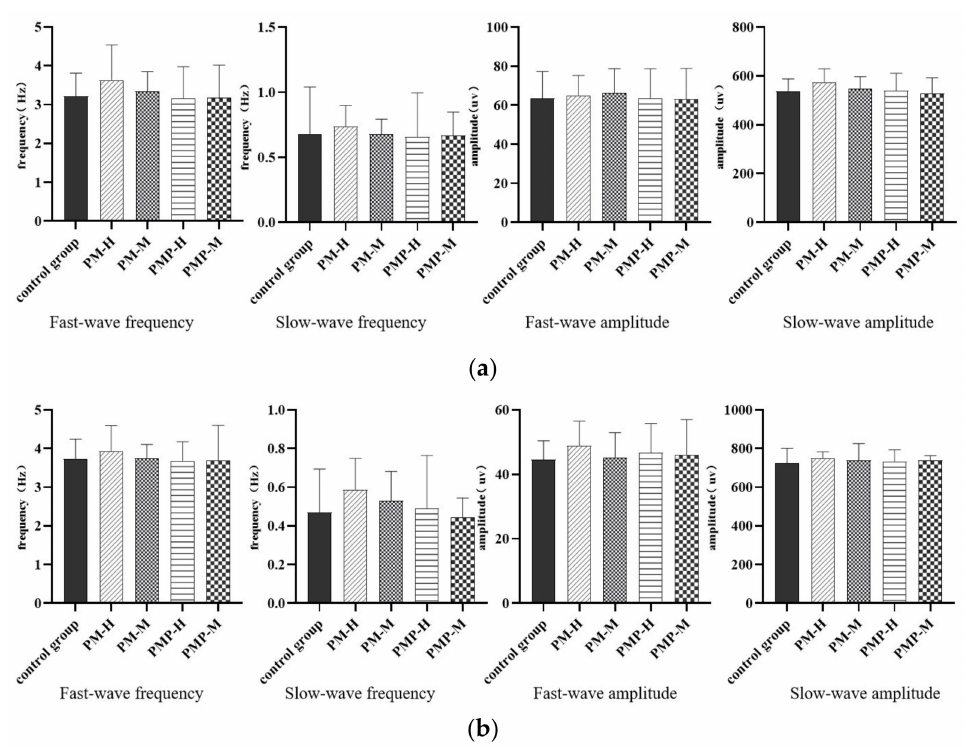
Figure 6. Gastrointestinal electromyography after drug withdrawal: stomach ( a ) and duodenum ( b ).